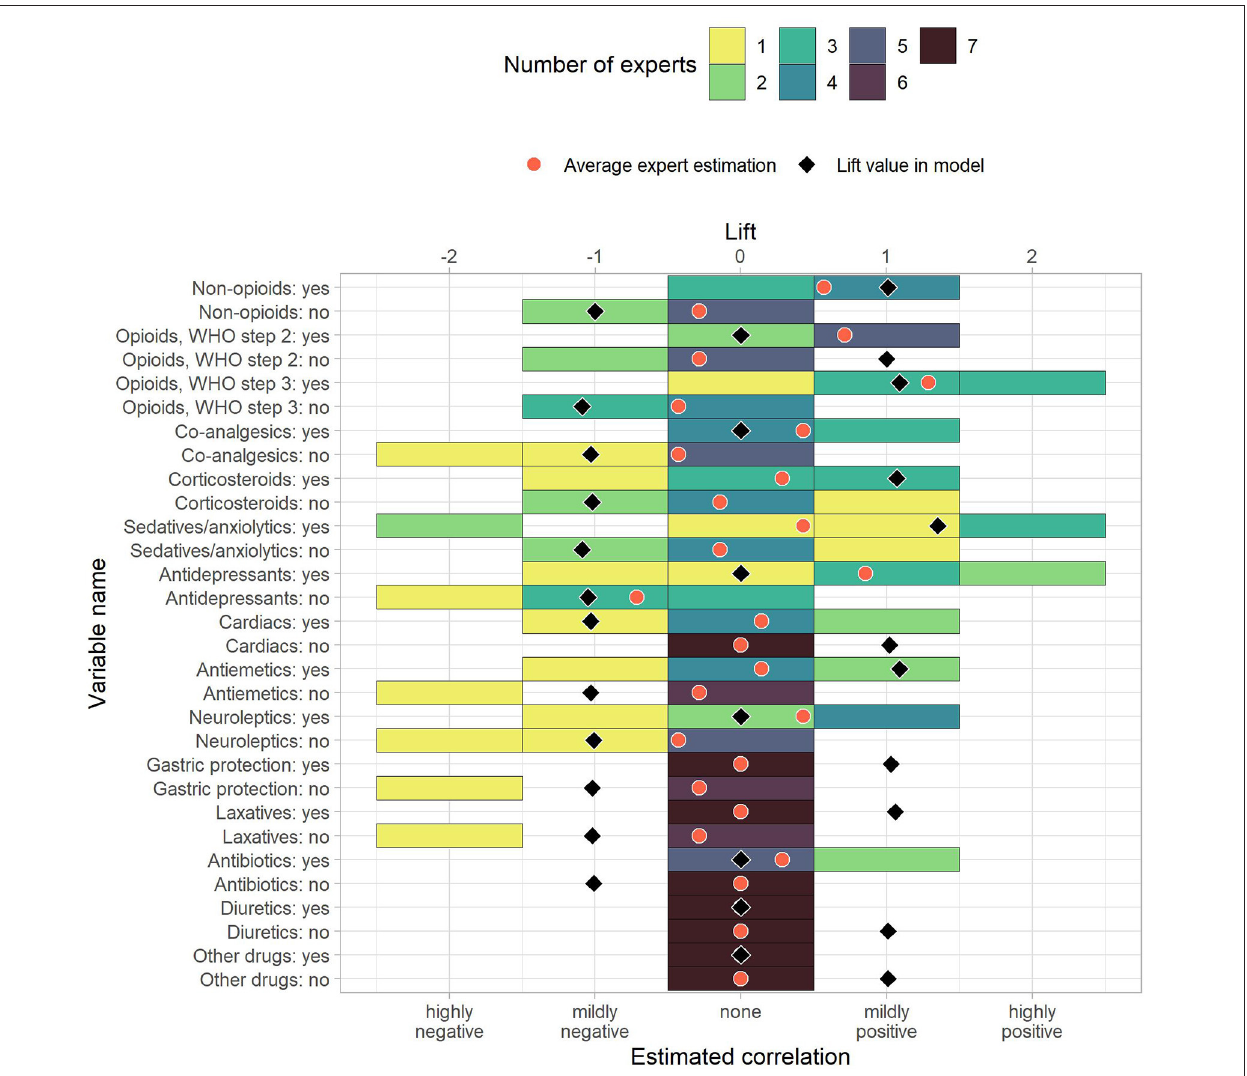
FIGURE 4 | The estimated correlations of HOPE variables to anxiety for drug uptake variables. The color indicates how many experts chose the corresponding option. The black diamond indicate the lift value of the corresponding variable in the model, where 0 stands for “not part of the model” and negative values correspond to the lift of no-rules. The red dot is the average expert